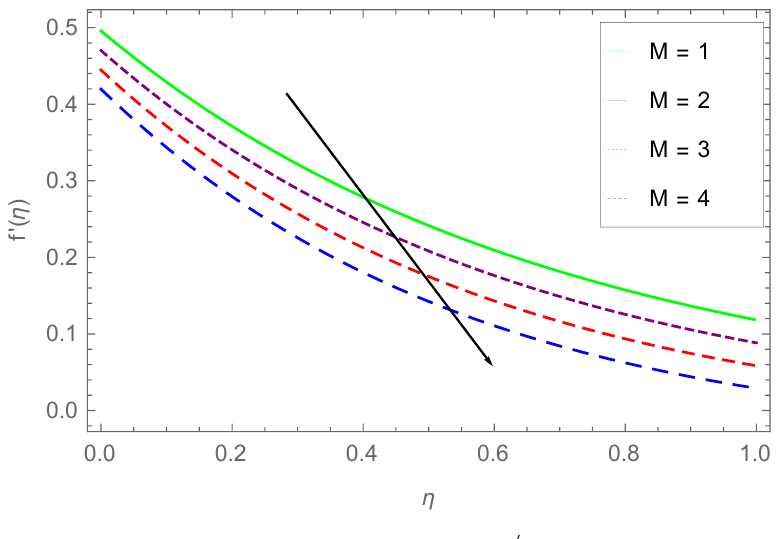
Figure 2. Influence of M on f (cid:48) ( η )